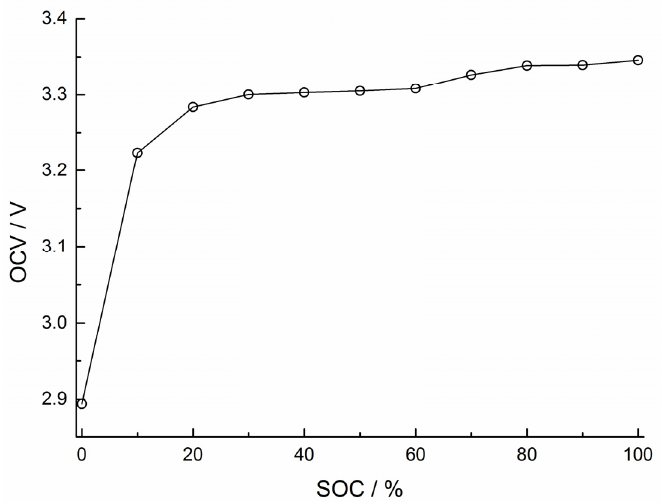
Figure 3. OCV-SOC curve of the battery.